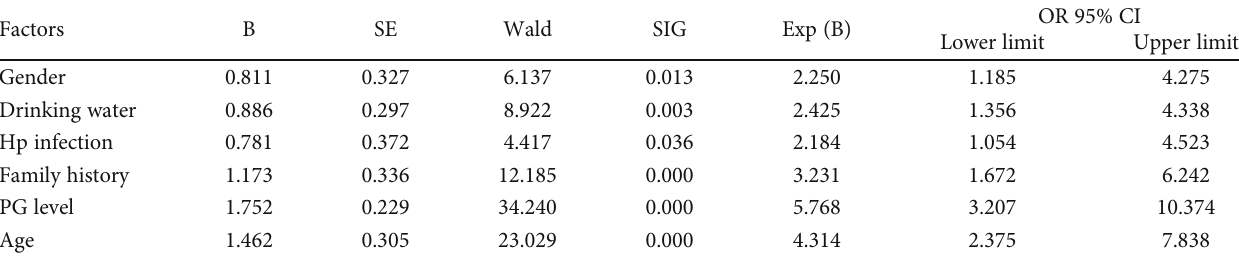
Table 3: Results of logistic regression analysis.